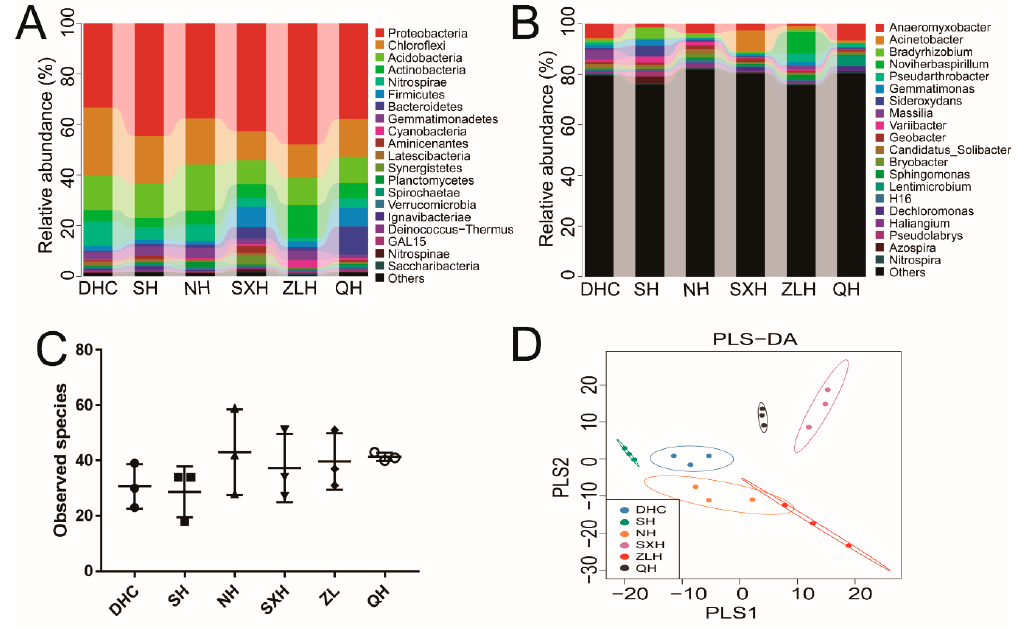
Figure 5. The diversity and richness of sludge bacteria among the DHC, SH, NH, SXH, ZLH and